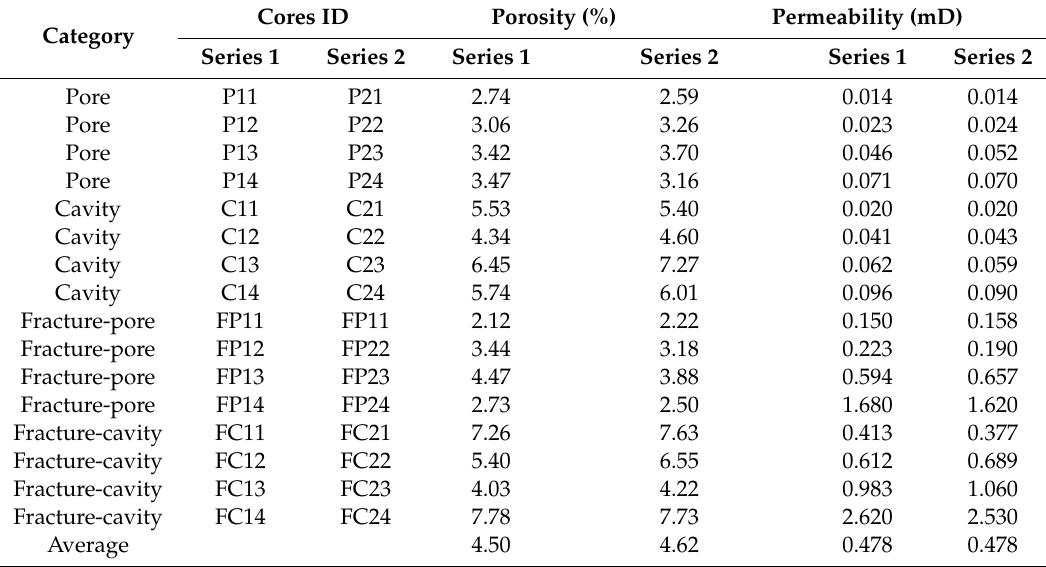
Table 1. Core parameters of Series 1 and